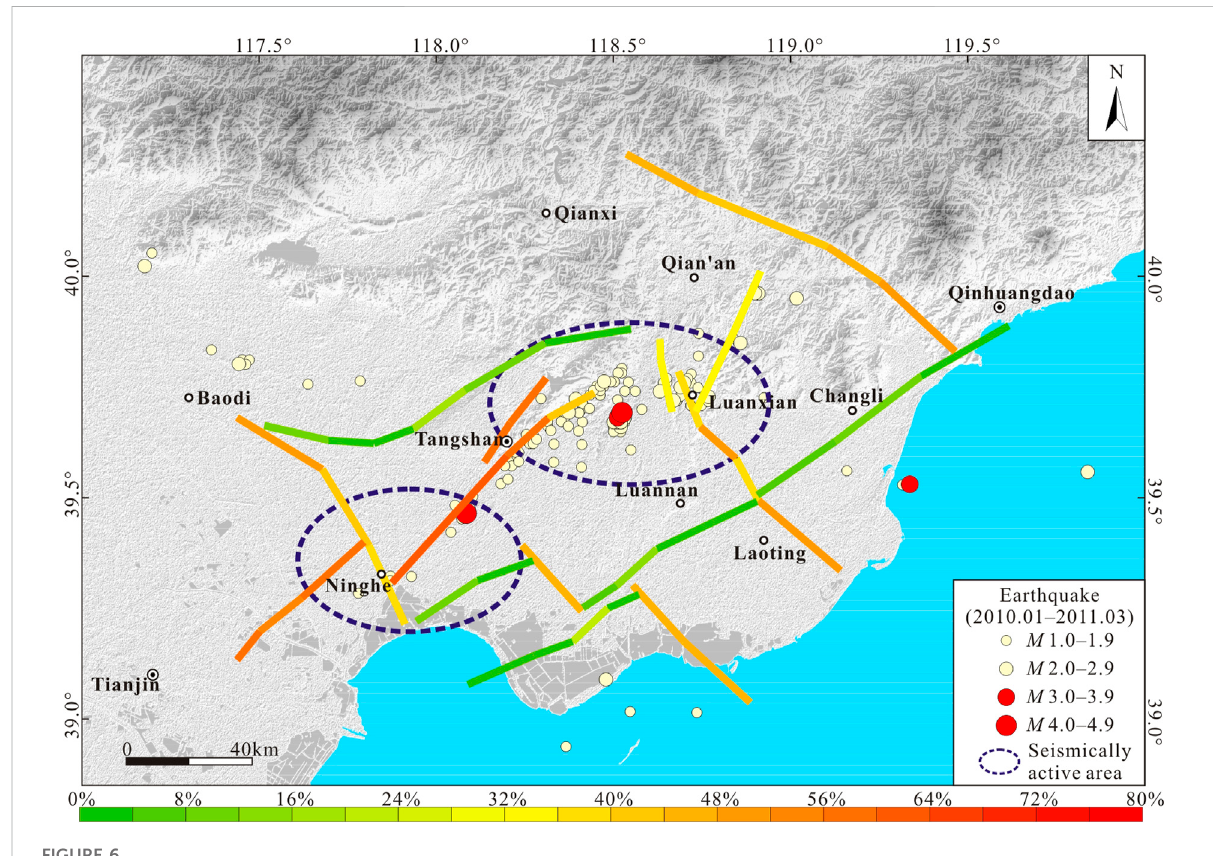
FIGURE 6 The fault slip potential on the main faults in Tangshan seismic region before the 3.11 Japan